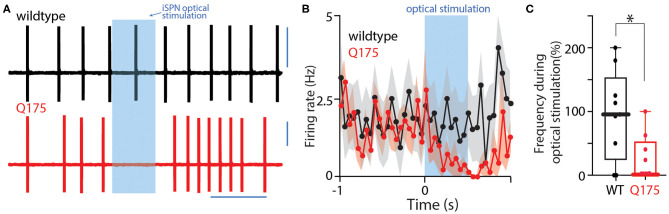
Optogenetic activation of iSPNs inhibits spontaneous ChI firing. (A) Sample current clamp recordings from spontaneously firing ChIs in a cell attached configuration. Strong activation of iSPNs induce a pause in activity. (B) Peristimulus time histogram of firing rate before, during, and after a high frequency stimulus. Error bars indicate standard error of the mean. (C) Boxplot showing that during optogenetic 10-pulse train activation of iSPNs, ChIs from zQ175+/− mice decrease their spontaneous firing rate. *P < 0.05.